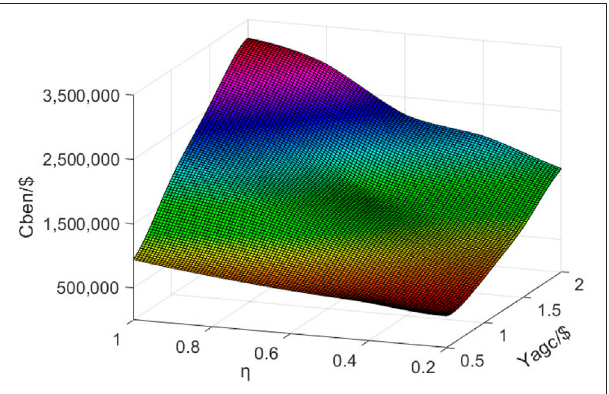
FIGURE 6 | Annual net bene fi t changes of HESS under different operating parameters. Results of different optimization